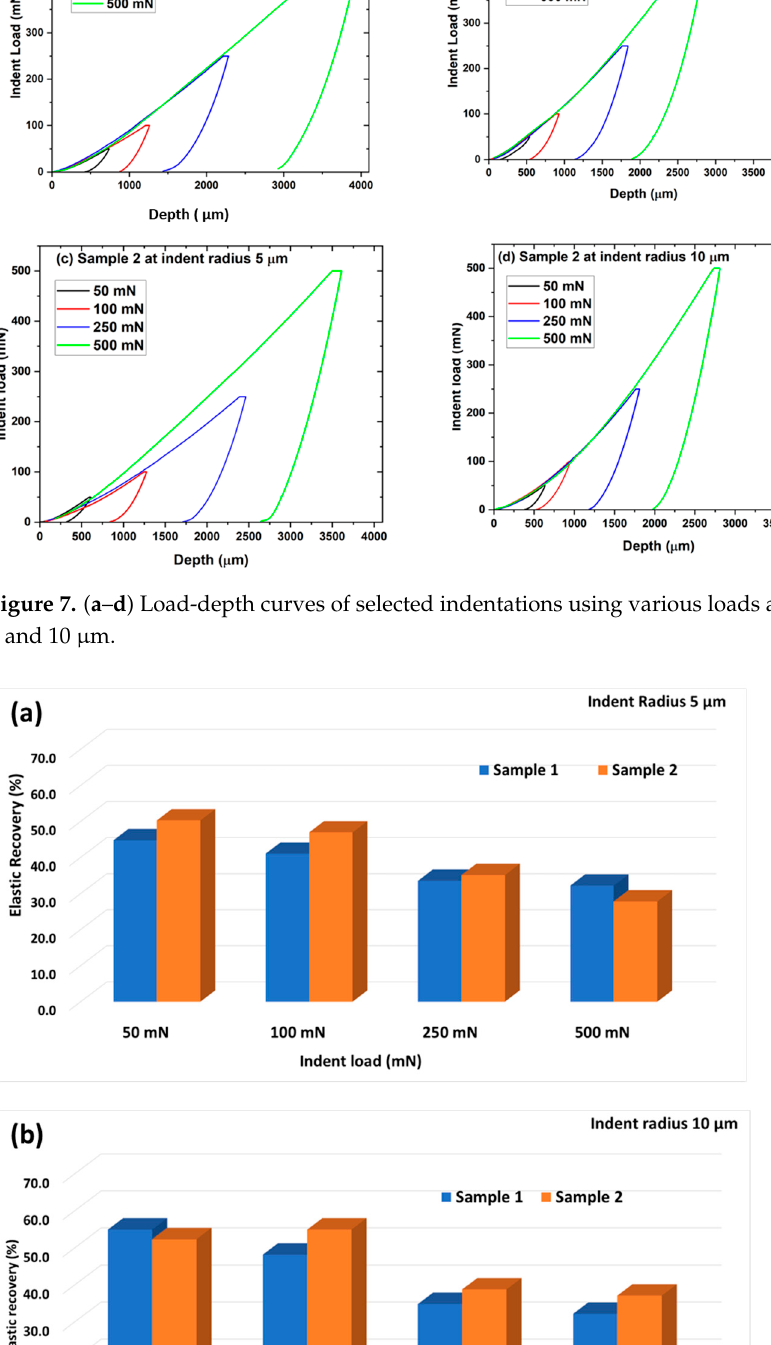
Figure 6. ( a ) Hardness and ( b ) reduced modulus of samples 1 and 2 at various loads with indenter radii of 5 and 10 μ m.